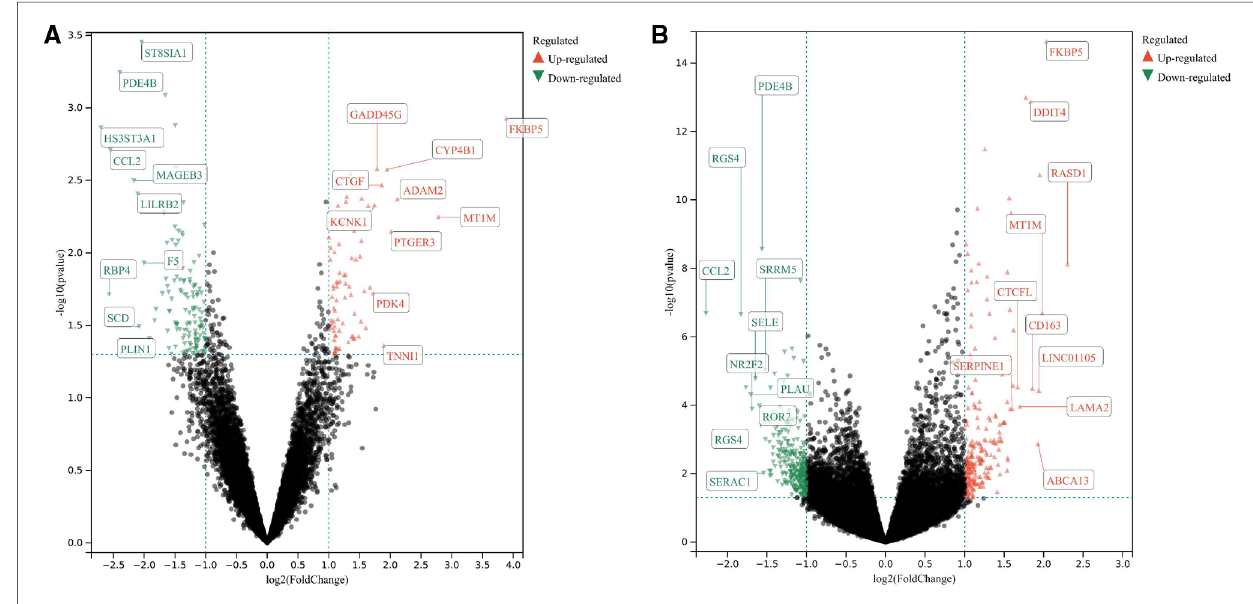
FIGURE 1 ( A ) Volcanic map of the GSE430 dataset; ( B ) volcanic map of the GSE21610 dataset. All genes were presented in volcano plots. Red ones were upregulated DEGs, green ones were downregulated DEGs, and black ones were the rest of the genes. The name of the top 10 upregulated and downregulated DEGs are shown in the volcanic plots. DEGs: differentially expressed